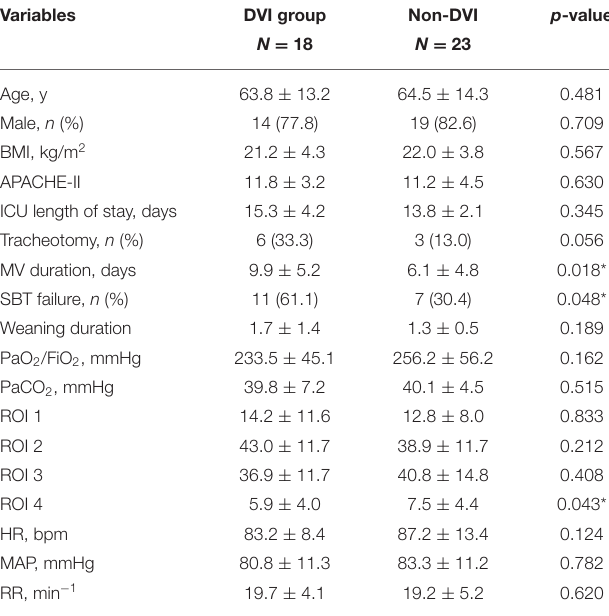
TABLE 3 | Comparison baseline date in DVI group and Non-DVI group.